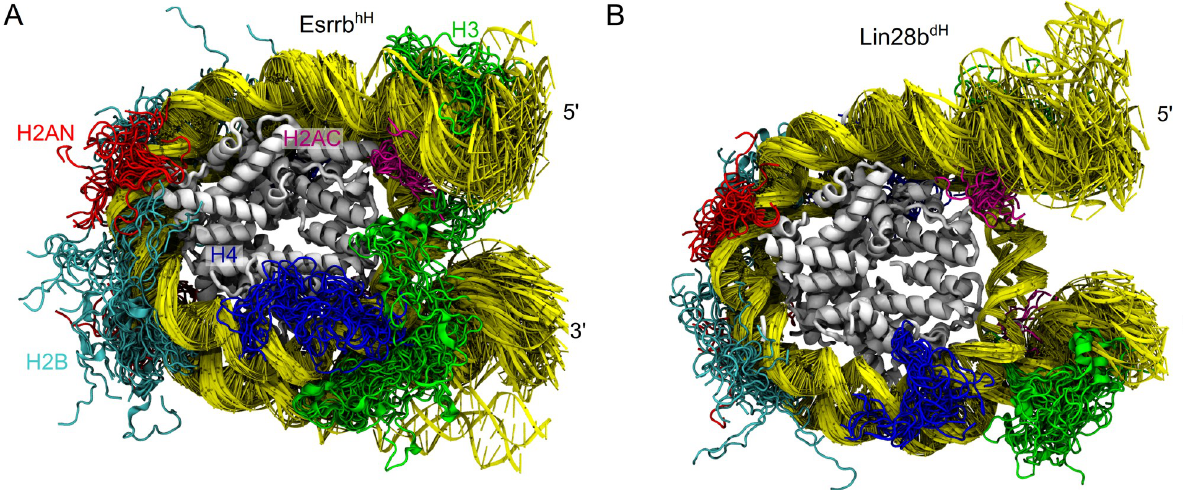
Fig 1. Nucleosome motions on the μ s time scale. Superposition of nucleosome snapshots taken from the 3 μ s simulation ensembles in which the major opening events occurred. (A) Esrrb hH (B) Lin28b dH . Tails are shown every 100ns, the DNA every 50 ns. The histone core is in gray, DNA in yellow. The histone tails of H3, H4, H2A (both N and C terminal) and H2B are in green, blue, red, magenta and cyan respectively.